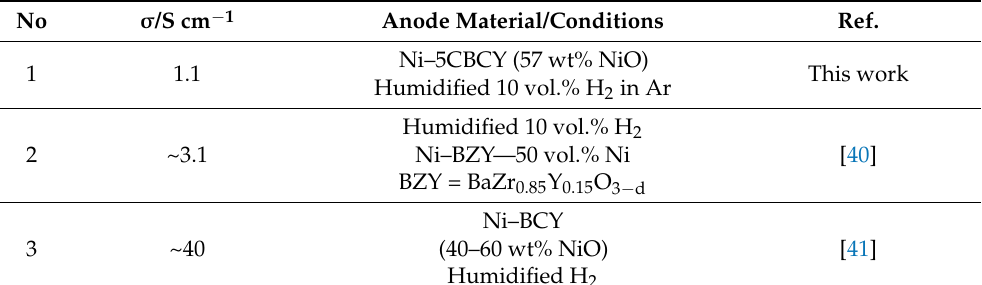
Table 2. Comparison of the electrical conductivity ( σ ) of Ni–5CBCY; Ni-BCY and Ni-BZY anode materials at 700 ◦